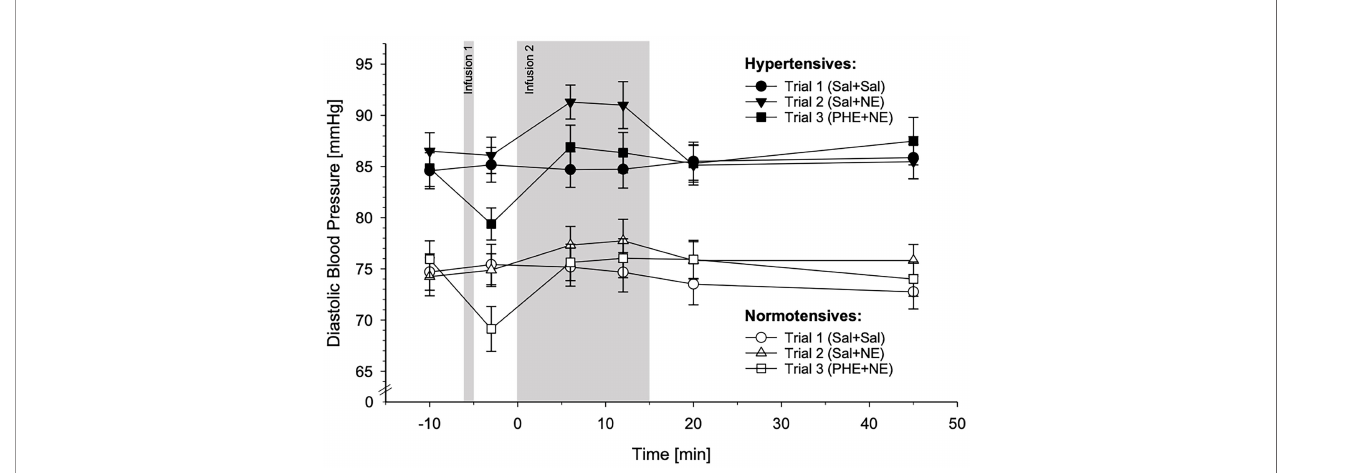
FIGURE 4 | Diastolic blood pressure (DBP) reactivity to the three different substance infusion-trials (trial 1: Sal+Sal, circles; trial 2: Sal+NE, triangles; trial 3: PHE+NE, rectangles) in hypertensive participants (HT; black symbols; n = 23) and normotensive controls (NT; white symbols; n = 24) ( mean ± SEM ). DBP reactivity differed across the three trials between HT and NT as revealed by the calculated general linear model (interaction trials-by-group-by-time: p = .014). Pairwise trial comparisons by means of general linear models : In comparison to NT, HT displayed higher DBP reactivity to Sal+NE as compared to Sal+Sal ( p = .007). PHE-induced a -adrenergic receptor blockade dampened reactivity to NE in both, HT and NT, resulting in similar reactivity to Sal+Sal and PHE+NE (Sal+Sal vs. PHE+NE: p = .55; Sal+NE vs. PHE+NE: p = .024). Within each trial by means of repeated measures ANCOVAs : DBP reactivity of HT and NT to did not differ to Sal+Sal and PHE+NE ( p ’ s ≥ .26) but to Sal+NE where HT exhibited higher reactivity as compared to NT ( p =